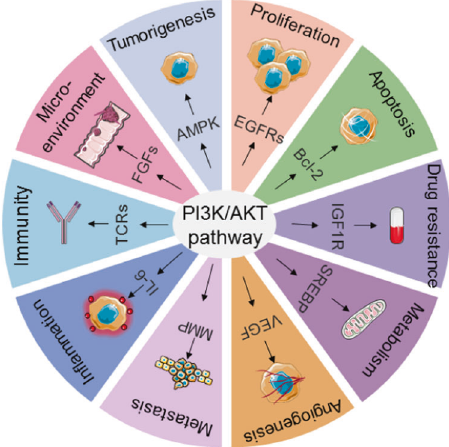
Fig. 3 PI3K/Akt signaling and cancer. Various biological processes are regulated by the PI3K/Akt pathway via key